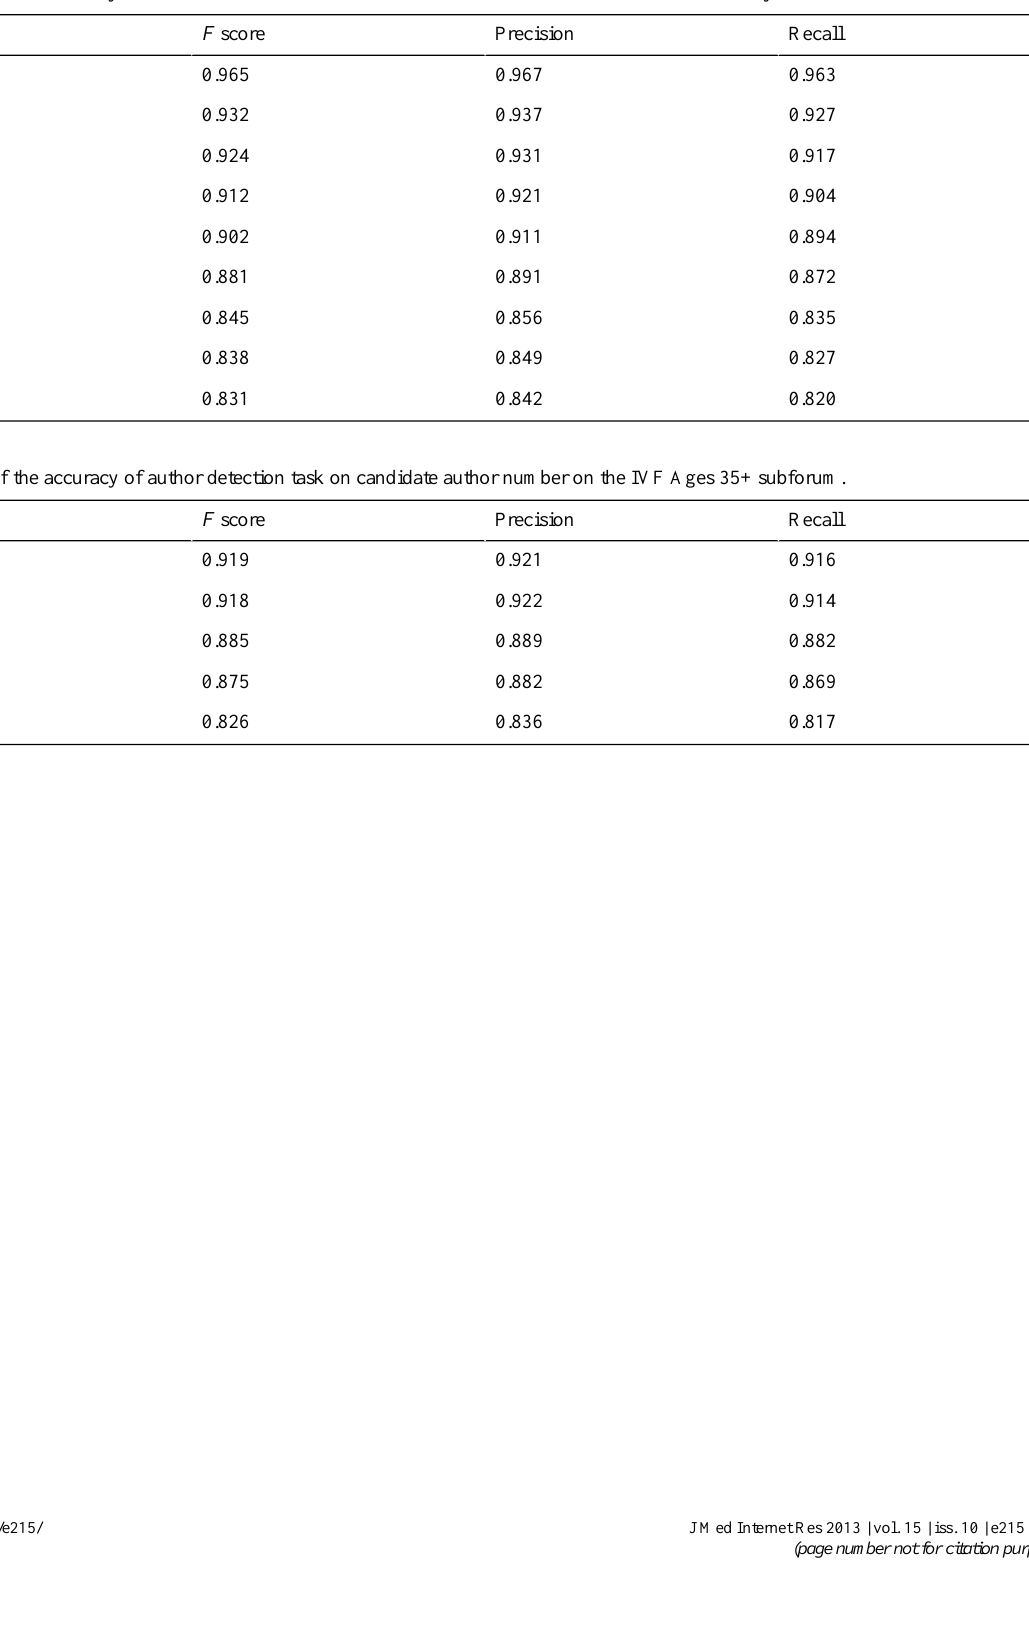
Table 5. Dependency of the accuracy of author detection task on candidate author number on the IVF/FET/IUI Cycle Buddies subforum.